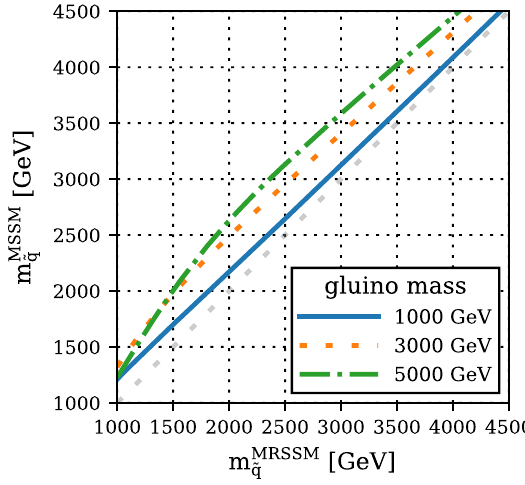
Figure 5 . Contours in the MSSM squark mass vs. the MRSSM squark mass plane for masses for which cross sections for 1st and 2nd generation squark production are equal in both